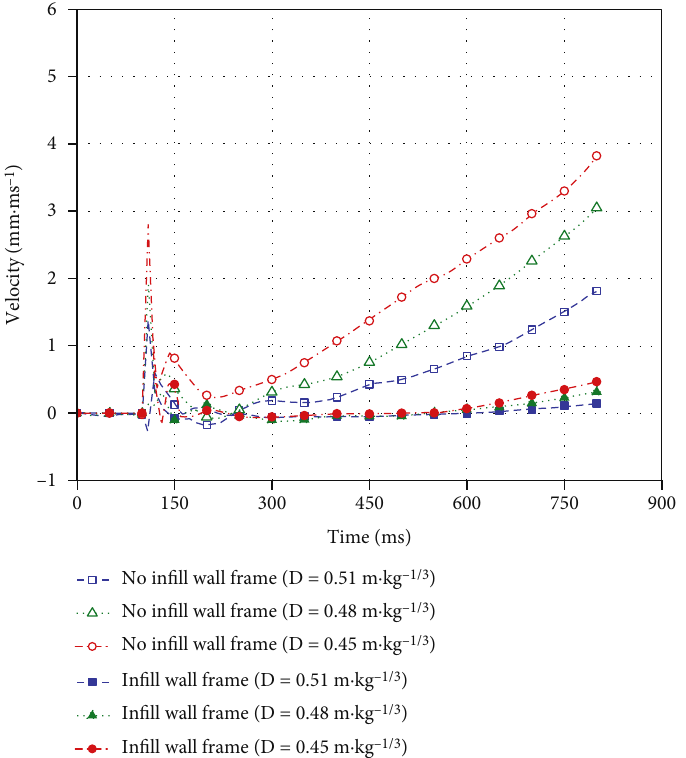
Figure 8: The Y -direction velocity of column midpoint in the second fl oor.